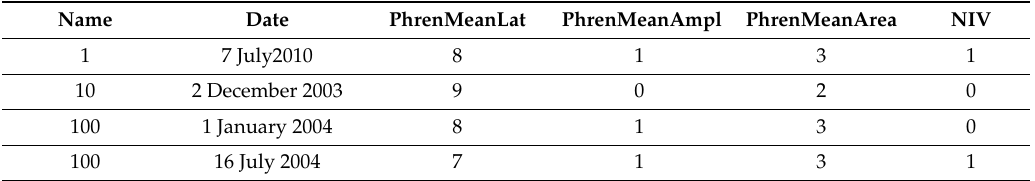
Table 10. Phrenic output table; generated using phrenic and demographics (NIV) original input information.